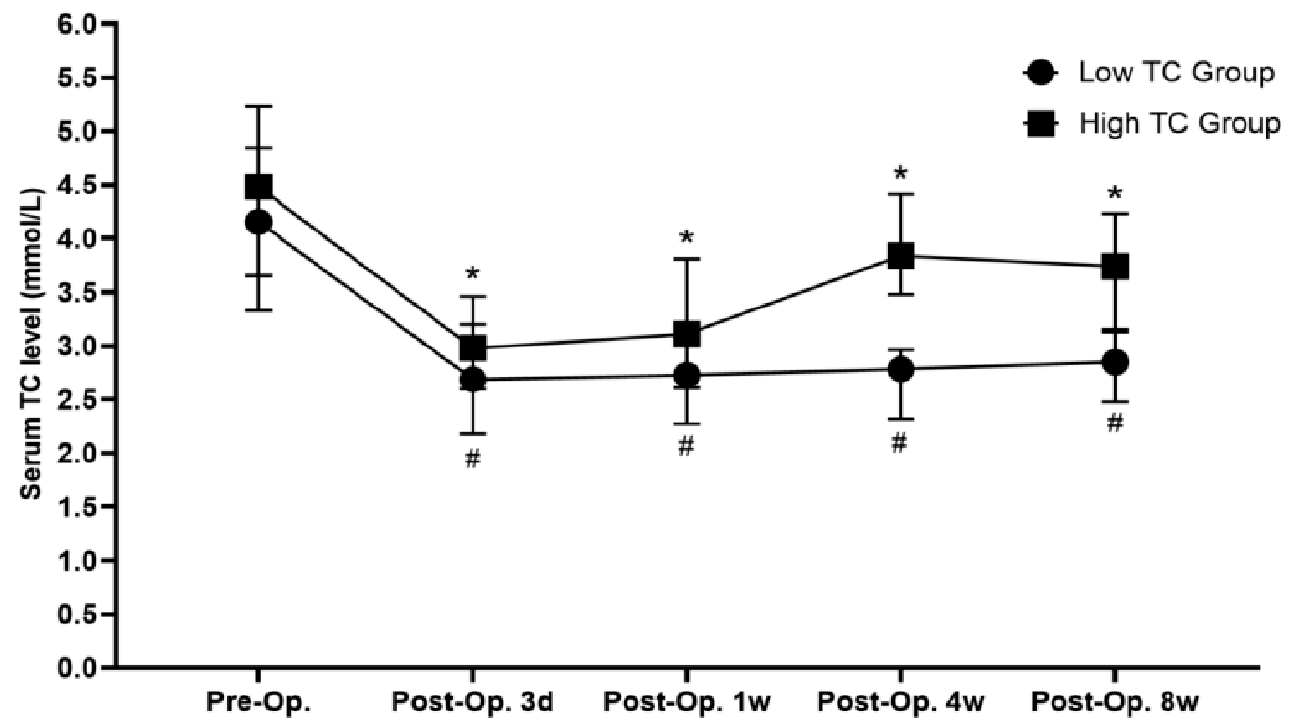
Figure 5. Variation in serum TC in the low-TC group and high-TC group perioperatively (*: compared